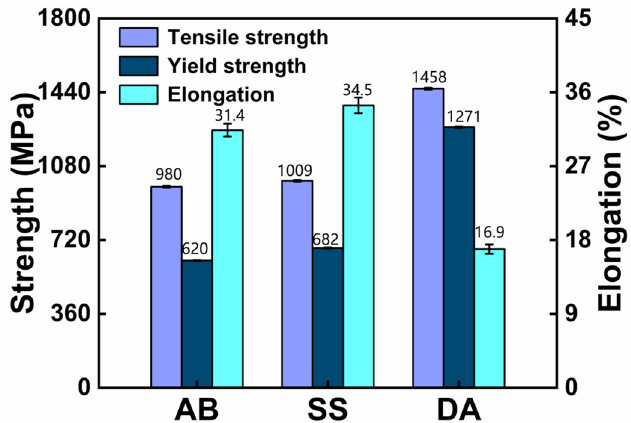
Figure 9. Tensile characteristics of the samples at room temperature.